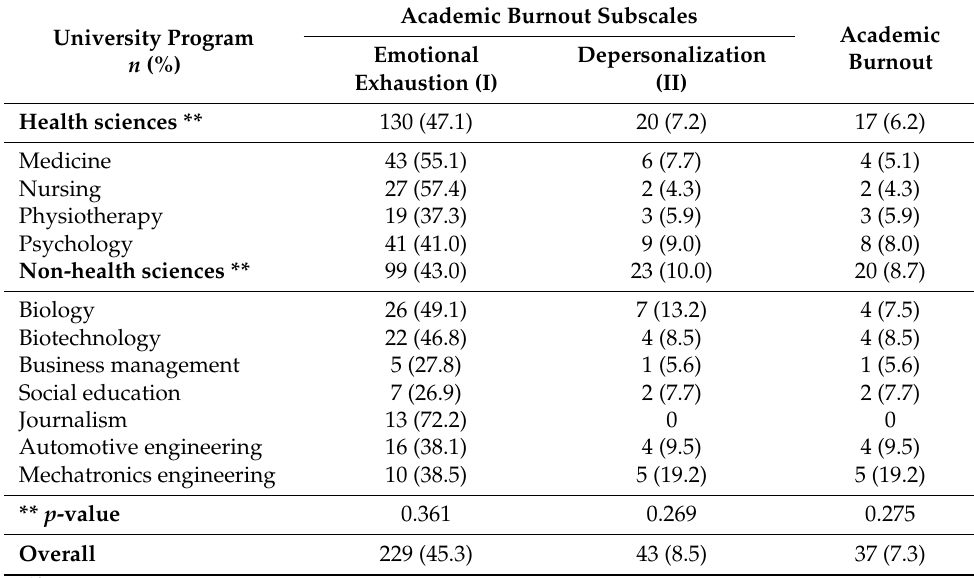
Table 3. Prevalence of academic burnout ( n = 506). Values are expressed as number of students, and percentages in brackets.